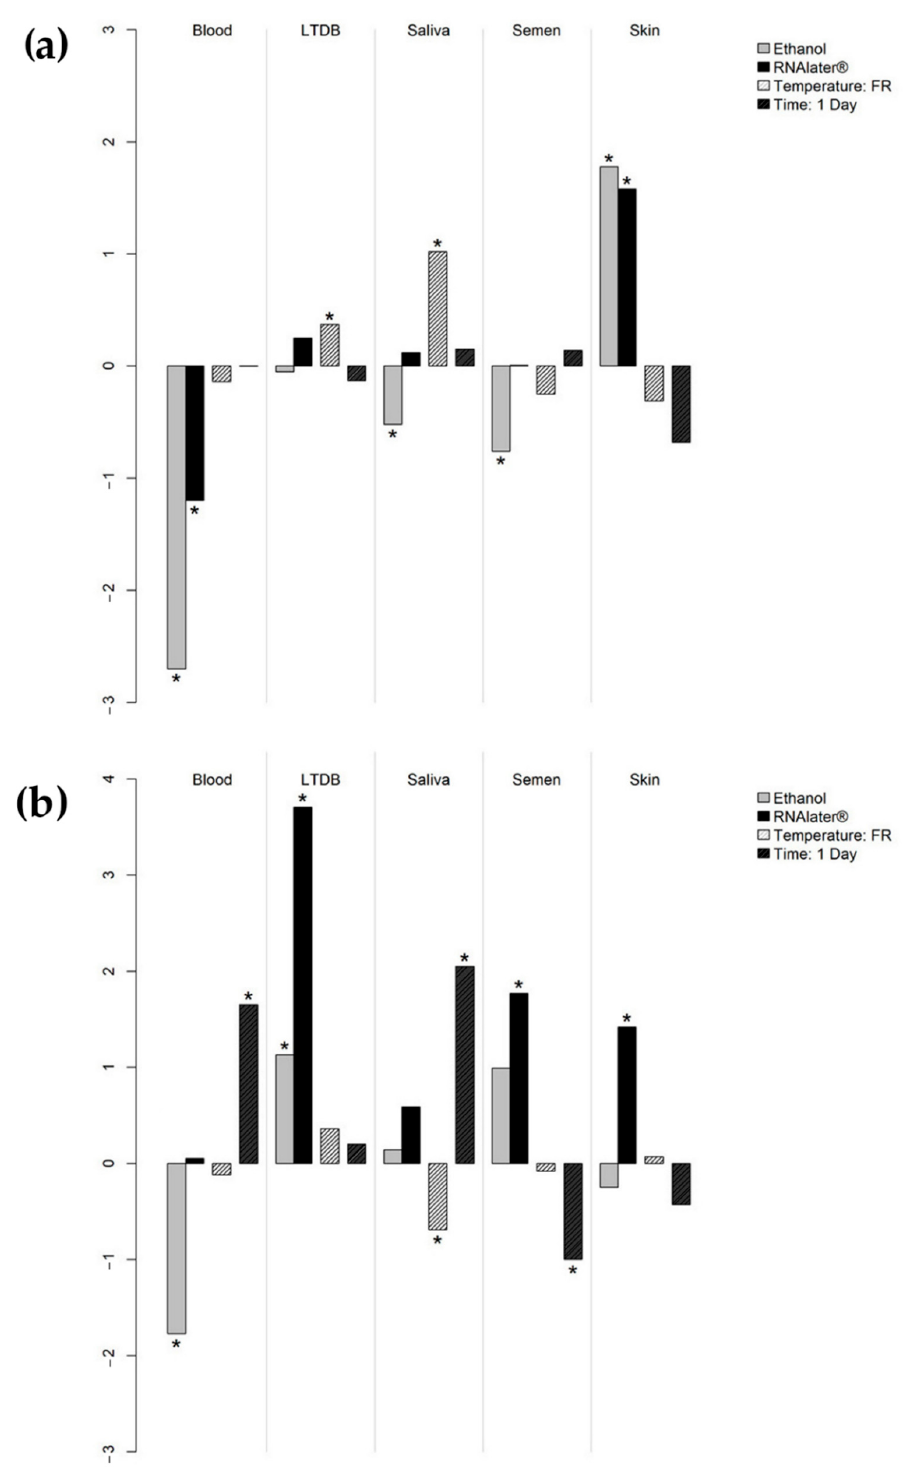
Figure 1. Coefficients on the y -axis (log scale) represent the mean increase or decrease in genomic DNA ( a ) and total RNA ( b ) concentrations when different moistening agents, storage temperatures (FR: frozen), and storage times before processing were applied to collection swabs, compared to the standard procedure (i.e., swabs moistened with water and stored at room temperature for 7 days before extraction). Significant p -values are marked with an asterisk. LTDB: luminol-treated diluted blood.